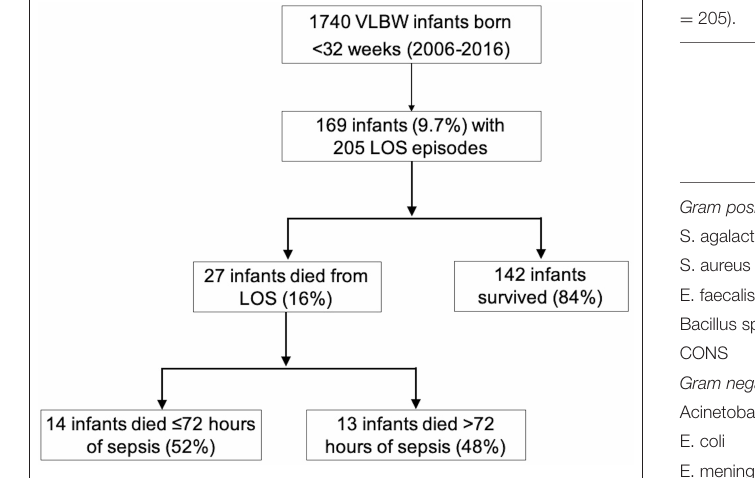
FIGURE 2 | Outcomes of preterm VLBW infants with late-onset sepsis.